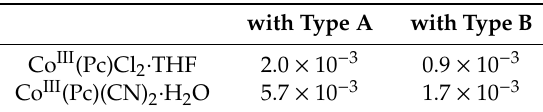
Comparison of the overlap integrals between similar three-dimensional systems